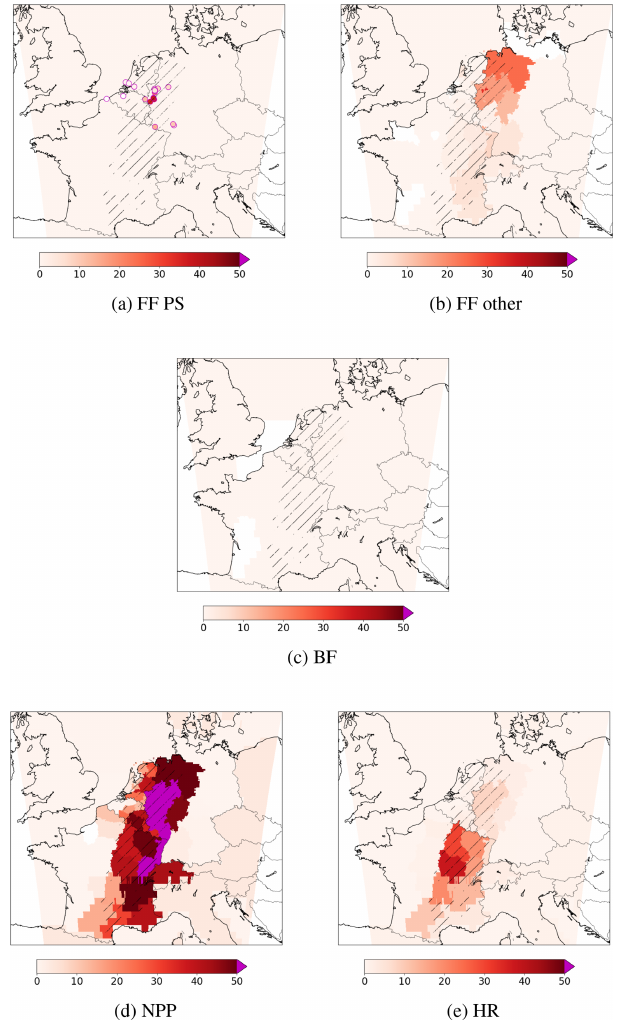
Figure 8. Uncertainty reduction in INV-Sat inversions: for morning budgets of large plants ( a , FF_PS, magenta circled dots), other FF (b) and BF ( c , crop and wood) emissions (urban area and rest of the region budgets), net primary production ( d , NPP), and heterotrophic respiration ( e , HR) (regional budgets). Stripes are indicative of the satellite field of view (see Fig. 6 for the full track).